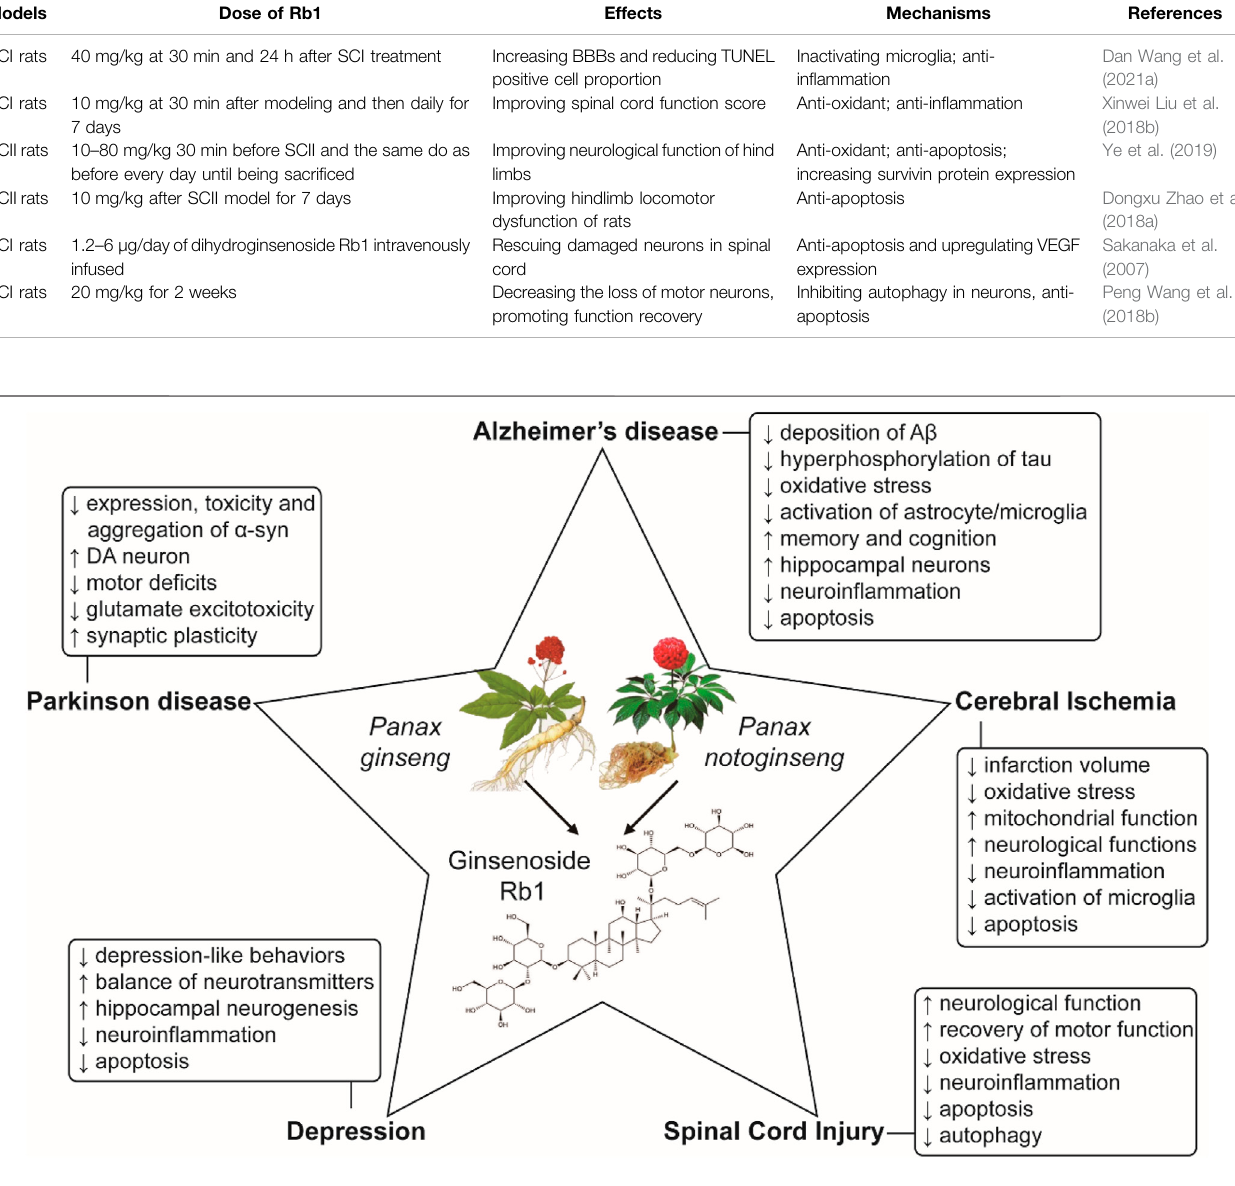
TABLE 5 | The neuroprotection of ginsenoside Rb1 in SCI.